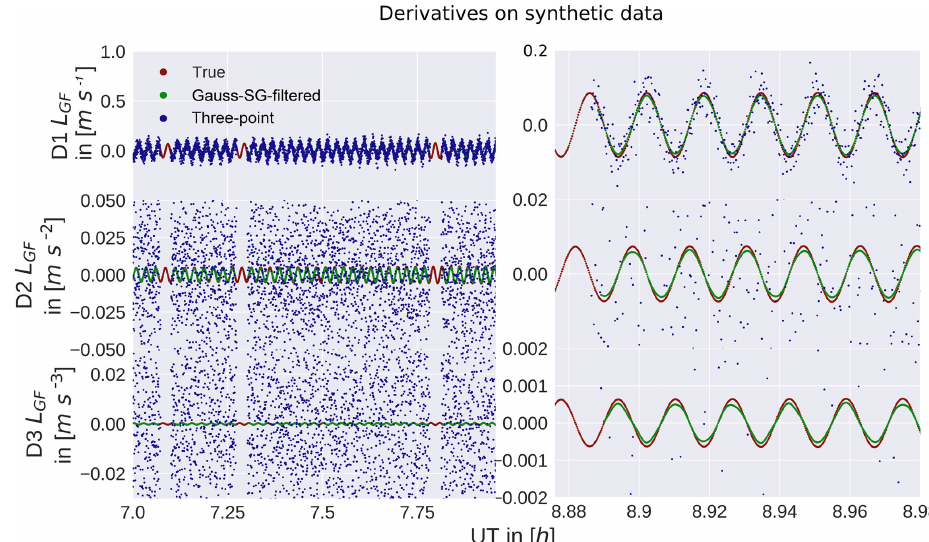
Figure 6. Tests on synthetic data. Red points show the true analytic noise-free derivative, green the computed derivatives from noisy data using the filter settings from Sect. 2.5 and blue points the three point derivative scheme. The noise in the second and third plot visible in the blue points exceeds the limit of the axis. The right side shows a zoom to compare the true derivative with the Gauss-SG filtered